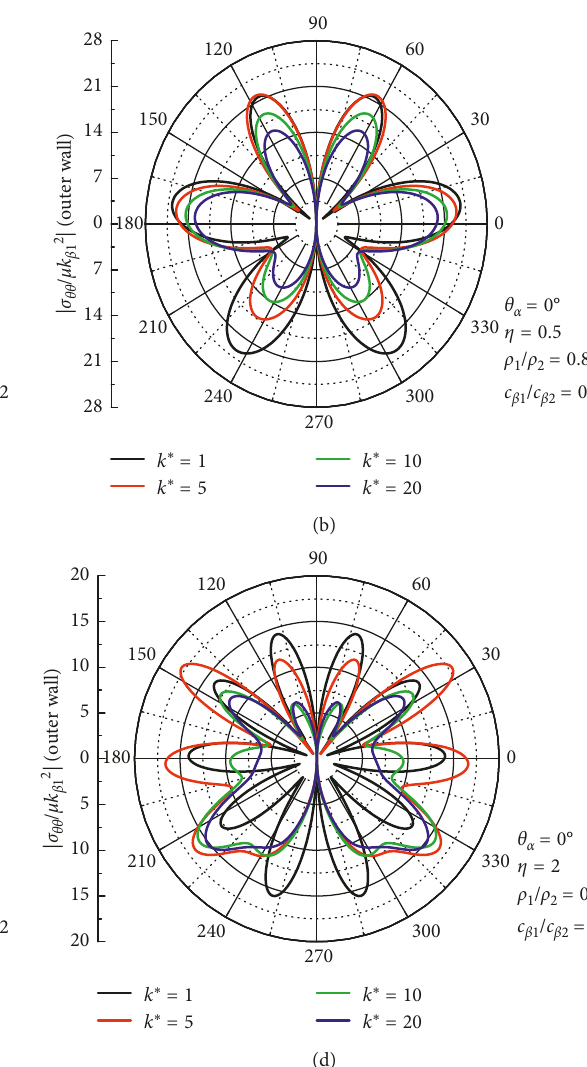
° ): (a) η 0 . 25; (b) η 0 . 5; (c) η 1; (d) η α (cid:29) 0 (cid:29) (cid:29) (cid:29) (cid:29)